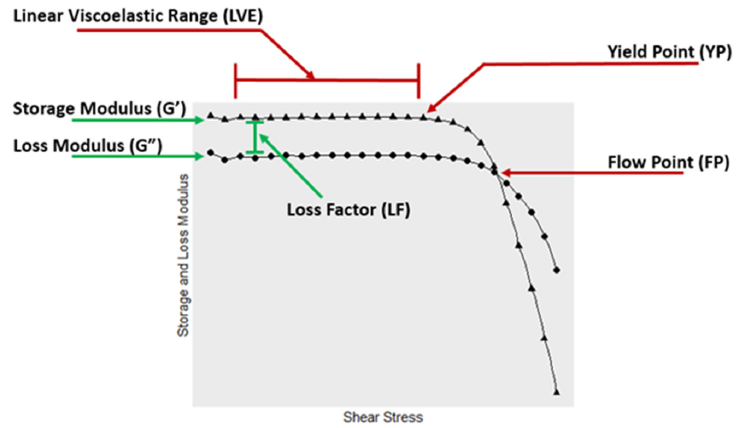
Figure 2. Standard log–log plot of a viscoelastic material where G’ is the storage modulus and G’’ is the loss modulus, and both are plotted against shear stress.